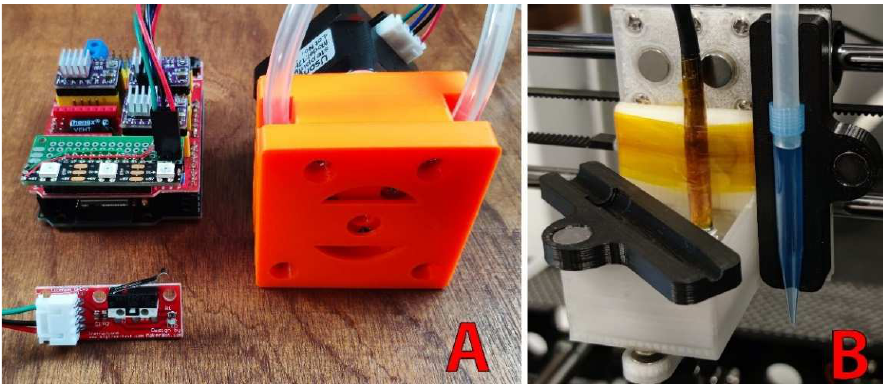
Figure 4. Automatic sampler. The sample preparation system is composed of a 3D-printed peristaltic pump [30] (orange; A ) connected to a micropipette tip held by a magnetic support (black; B ) placed next to the camera (white; B ).